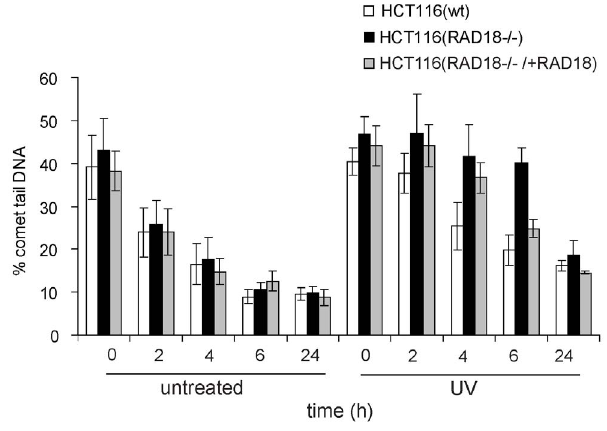
Figure 5. Time course curves of UV-irradiated HCT116(wt), HCT116(Rad18 2 / 2 ), and HCT116(RAD18 2 / 2 / + RAD18), which is a HCT116(Rad18 2 / 2 ) cell line expressing RAD18 for comple- mentation. Cells were BrdU pulse labelled and mock treated or irradiated with UV (20 J/m 2 ) and replication fork progression was followed by alkaline BrdU comet PRR assay. The % comet tail DNA, as a measure of discontinuity was monitored in untreated and in UV treated cells. Each data point represents the mean of three independent experiments. Error bars indicate standard deviations.